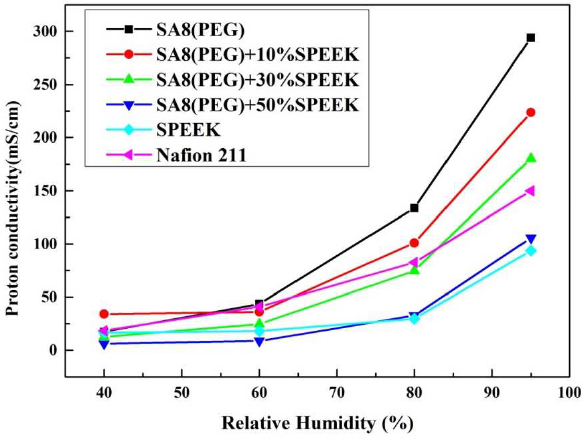
Figure 25. The proton conductivity diagram of SA8 blended with PEG and sPEEK. Table 7. Component measurement conditions and performance of SA8 blended with PEG and 10% sPEEK and 30%